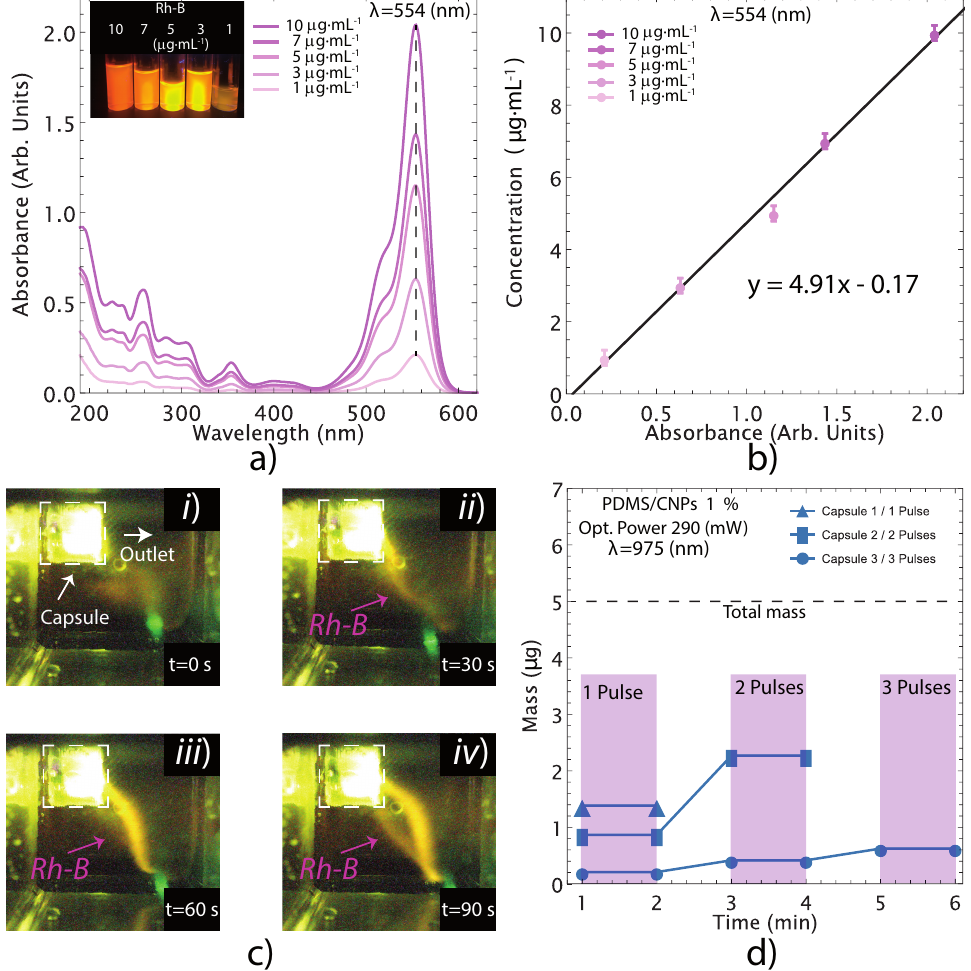
Figure 9. Evaluation of the liquid delivery from the devices using Rh-B as a fluorescent marker for visualization/quantification purposes: ( a ) UV-Vis spectra for Rh-B at different concentrations exhibiting its main peak at λ = 554 nm; ( b ) linear fitting of the concentration vs. absorbance data to obtain the calibration model; ( c ) visualization of Rh-B release under fluorescent imaging; one single long pulse for 90 s; and ( d ) quantification of Rh-B release through UV-Vis measurements. The release of the Rh-B from the device can be visualized in Video S2 of the Supplementary